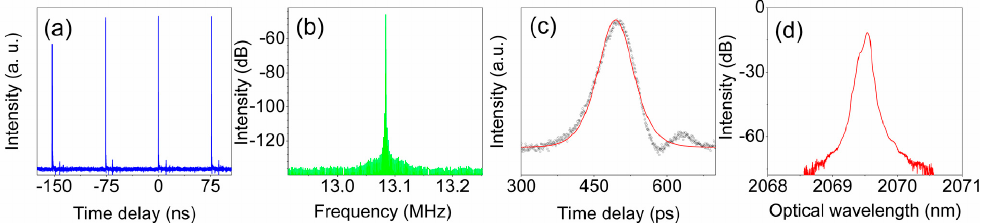
Figure 3. Laser with emission at 2.07 µ m. ( a ) Pulse train at the fundamental repetition rate. ( b ) RF spectrum showing the first harmonic. ( c ) Waveform of the single pulse in the time domain (solid black points) and its corresponding fitting by a square hyperbolic secant profile (solid red curve). ( d ) Measured spectrum of the output.